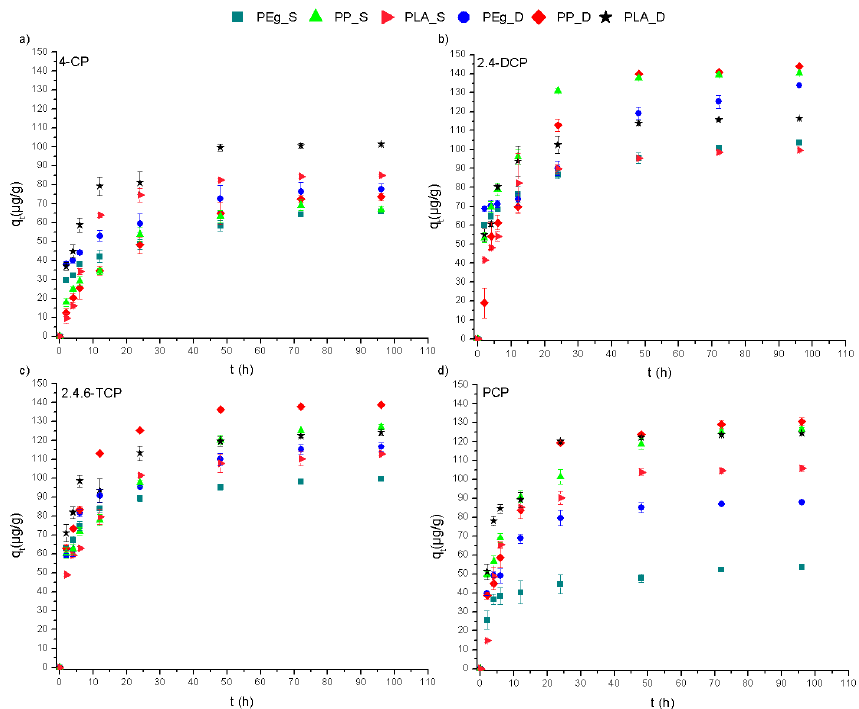
Figure 1. Experimental data (n = 3, mean value ±SD) of ( a ) 4-CP; ( b ) 2,4-DCP; ( c ) 2,4,6-TCP and ( d ) PCP on PEg, PP and PLA particles in the synthetic matrix (PEg_S, PP_S and PLA_S) and Danube river water (PEg_D, PP_D and PLA_D).